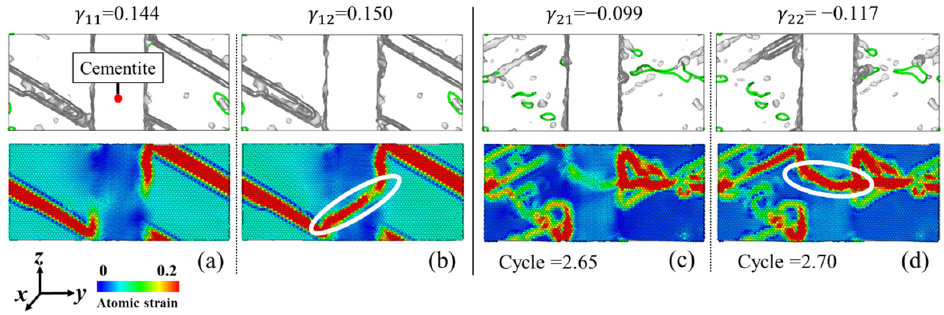
Figure 14. Shear deformation and shear slip threshold of cementite phase. ( a , b ) is under monotonic shear deformation; ( c , d ) is under cyclic shear deformation. Loading directions are both along the x - axis.